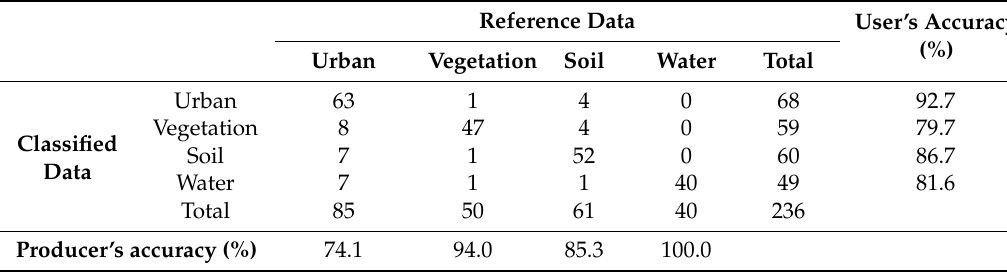
Table 2. Confusion matrix of accuracy assessment of the land cover classification for